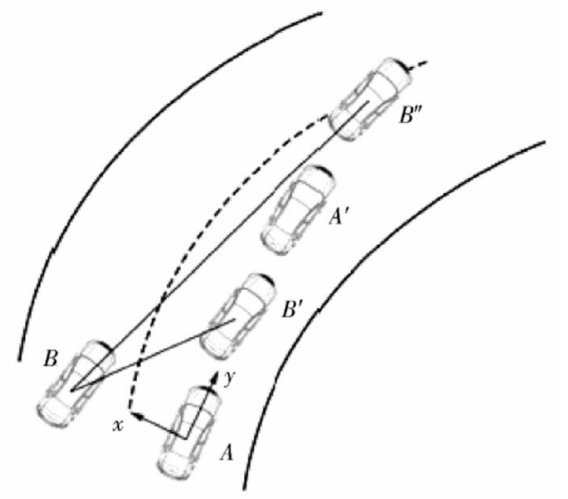
Figure 18. New lateral safe distance